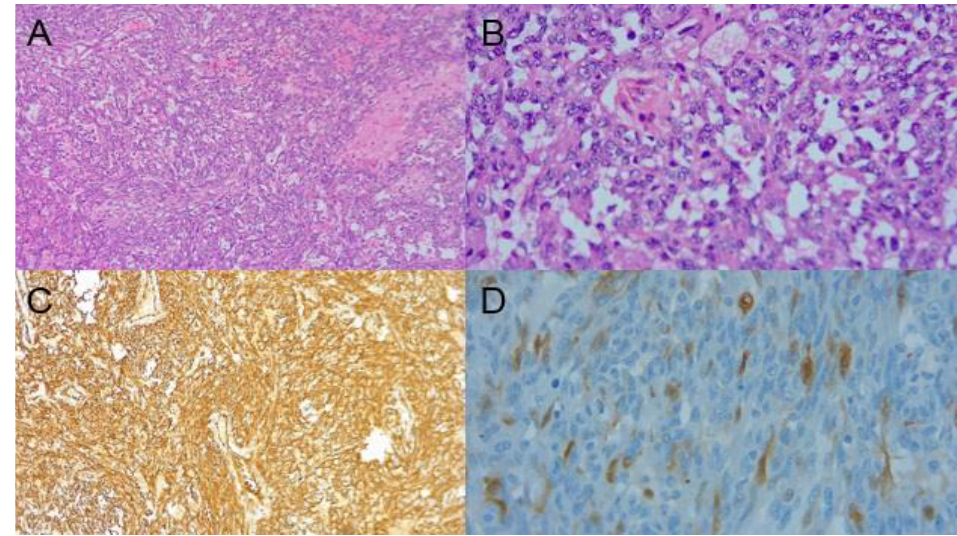
Figure 3. ( A ) H&E 10×; fuso-cellular proliferation with vascular channel formation. ( B ) H&E 40×; higher magnification shows cell population with slight to moderate atypia with vascular channel formation. ( C ) CD34 10×; vascular marker CD34 is diffusely positive in neoplastic cells. ( D ) P16 40×; marker P16 is focally positive in neoplastic cells. H&E = Hematoxylin and Eosin-Stained.